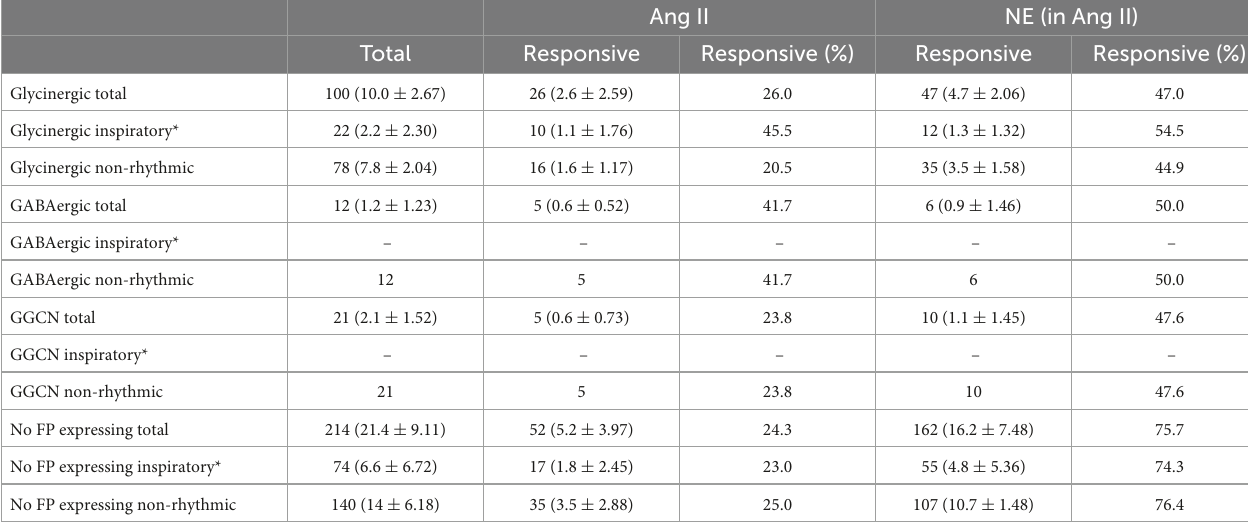
TABLE 1 Number of neurons, which responded to Ang II or to norepinephrine (NE; in the presence of Ang